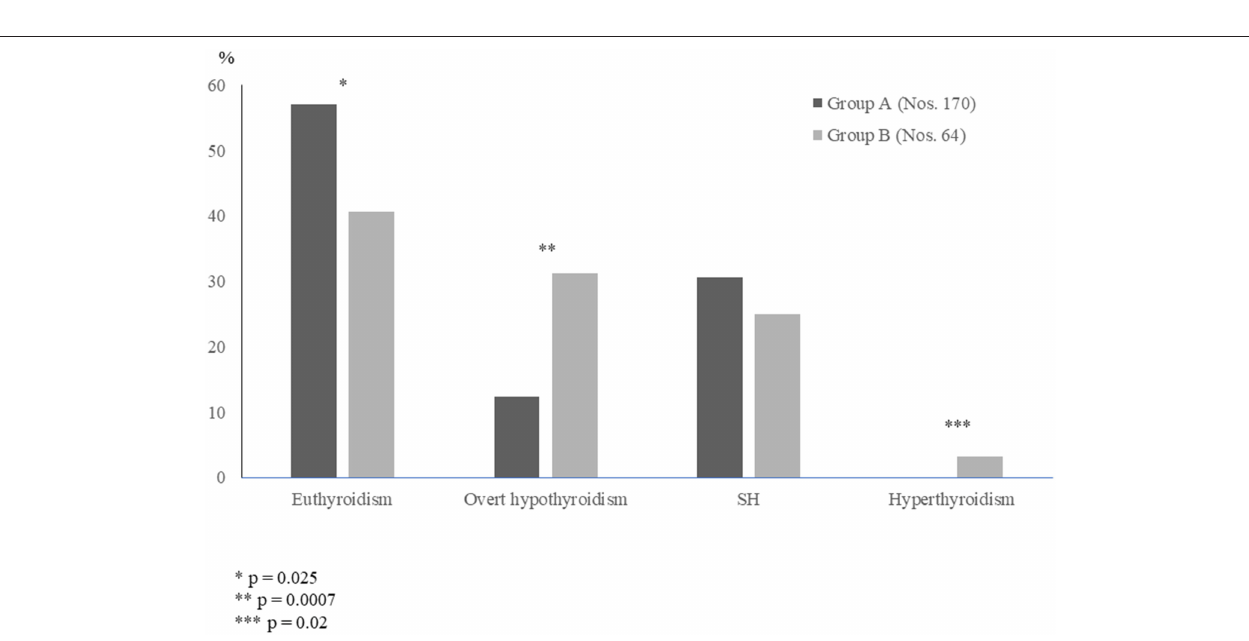
FIGURE 2 | Prevalence (%) of the different biochemical pictures of thyroid function found, at the end of a 5-year follow-up, in two groups of children with Hashimoto’s thyroiditis, who had initially presented with either euthyroidism (Group A) or subclinical hypothyroidism SH (Group B) (according to the results of [23] study).